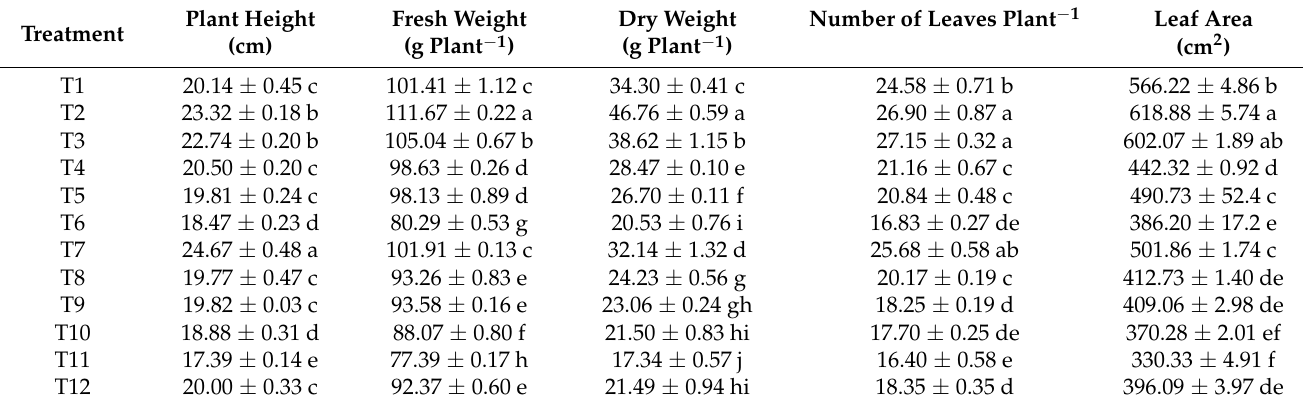
Table 3. Effect of potassium treatments on vegetative growth characteristics of strawberry plants in the combined seasons of 2019/2020 and 2020/2021.